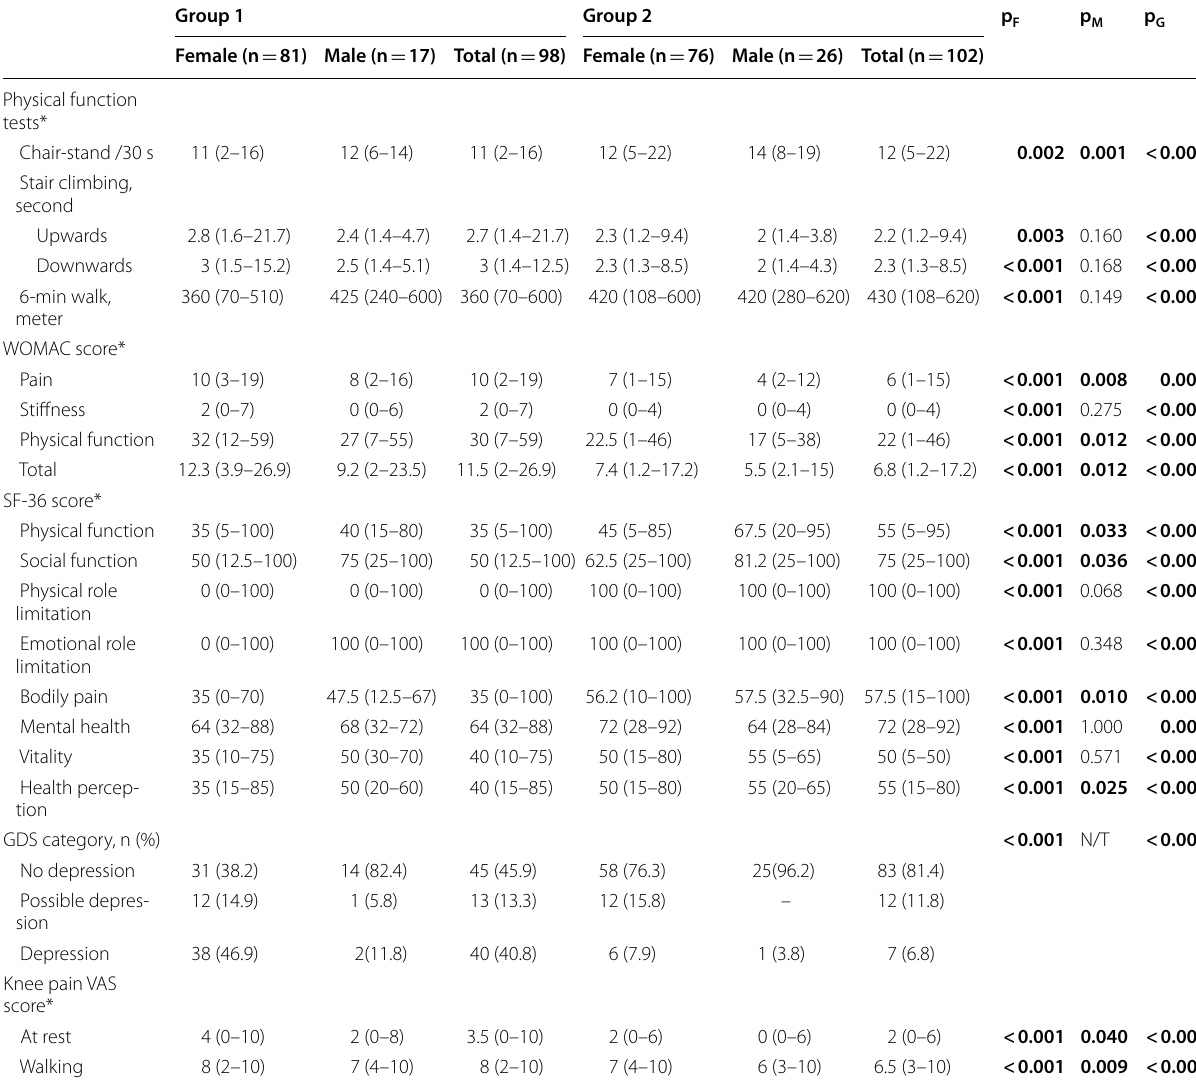
Table 3 Physical function tests, Western Ontario and McMaster Osteoarthritis Index (WOMAC), Short Form-36 (SF-36), geriatric depression scale (GDS), and knee pain visual analogue scale (VAS) scores of the study